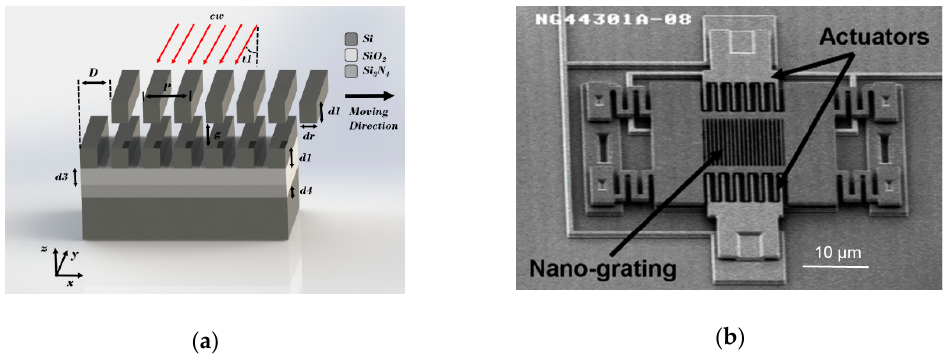
Figure 15. Schematic diagrams of the sub-wavelength gratings and the optical MEMS accelerometer developed by Carr and Keeler et al . at Sandia National Laboratory and Symphony Acoustics [69–71]: ( a ) cross section of laterally deformable sub-wavelength grating ([Reprinted] with permission from ref. [65] © The Optical Society); ( b ) SEM of fabricated optical MEMS accelerometer.